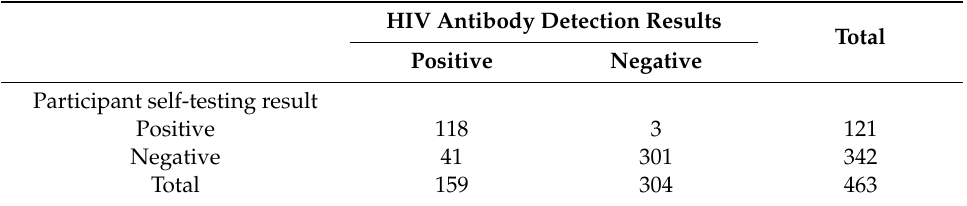
Table 3. Detection results according to type of test (n =